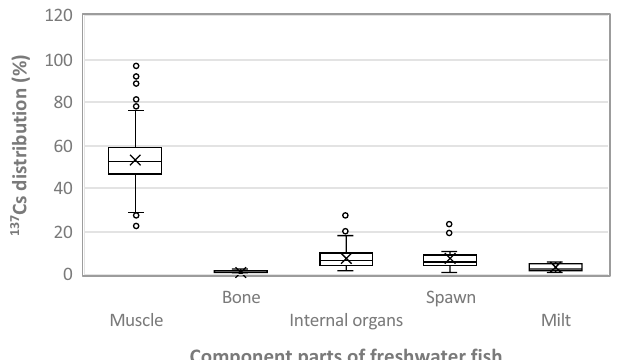
Figure 1. Boxplot showing the distribution of 137 Cs in muscle (n = 308), bone (n = 28), internal organs (n = 94), spawn (n = 38) and milt (n = 7) of all freshwater fishes caught in this study. Each box indicates the inter-quartile range. The line inside the box shows the median. Marks “×” and “open circles” are mean values and outliers, respectively. Significant difference was found for the Kruskal–Wallis test ( P < 0.01). The Steel–Dwass post-hoc test showed significant differences except between bone and milt, internal organ and spawn, and spawn and